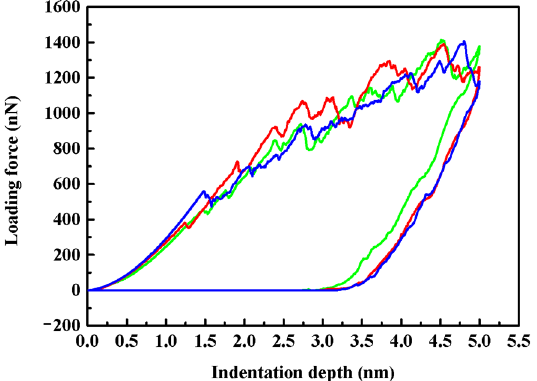
Figure 3. Loading forces as a function of indentation depth (P − h curves) for (001), (110), and (111) planes. Green, red, and blue lines represent the data of (001), (110), and (111) planes, respectively.